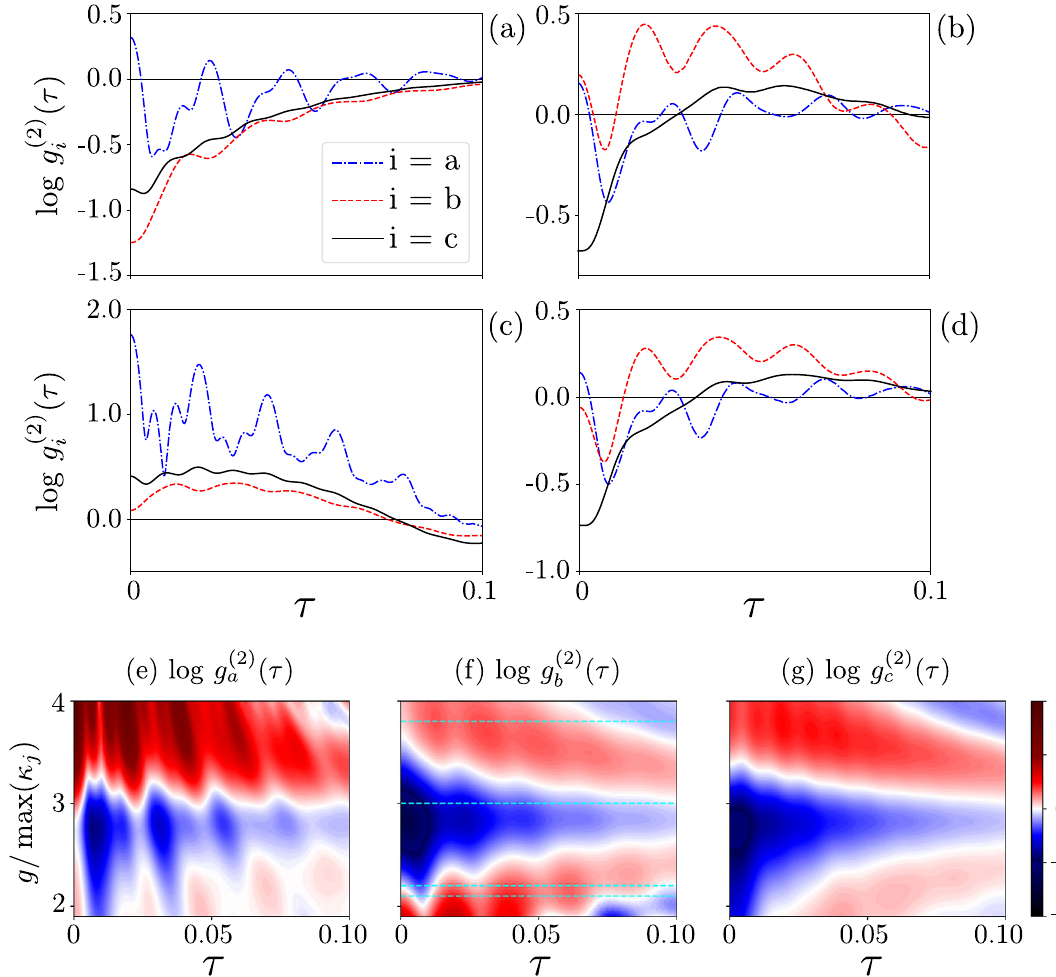
( 2 ) (τ) (in the logarithmic scale) for the SMR i